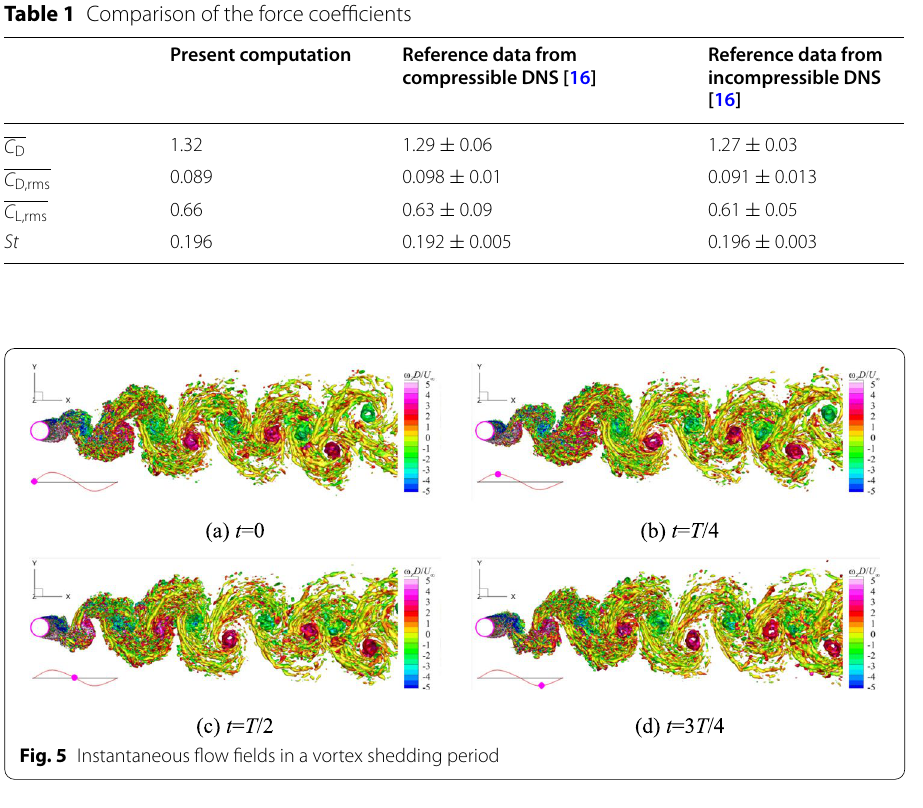
marked on the curves illustrate the time moments of the vortex shedding. The wakes are characterized by the isosurface of the Q -criterion [24] Q ( D / U indicating the contour of the spanwise vorticity, ω z D / U in the subcritical range. The wake near the cylinder immediately transitioned to turbu- lence. The vortex in the wake had abundant small-scale turbulent structures. The strong